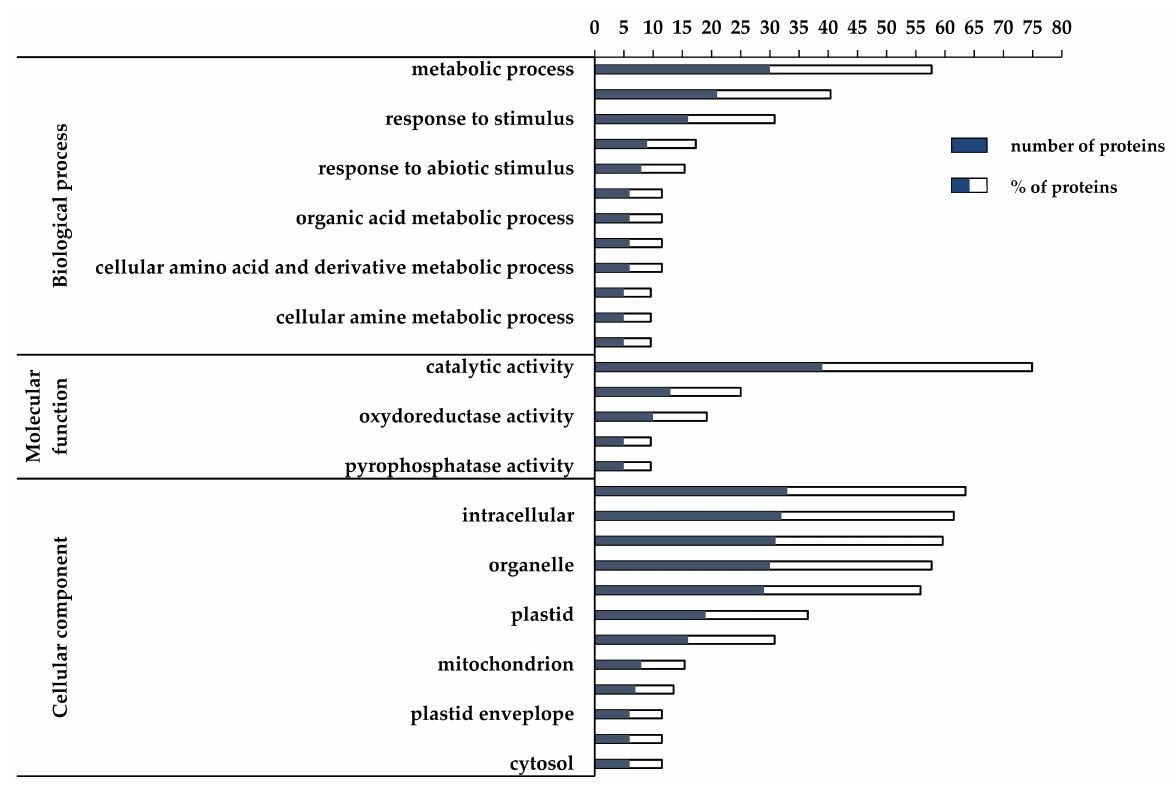
Figure 4. GO functional classification of the downregulated DEPs. The blue bar represents the number of downregulated proteins included in each GO term, whereas the sum of blue and white bars represents the corresponding protein percentage. As for the downregulated DEPs, 30/52 DEPs (58%) matched with the “metabolic process term” (GO:0008152, FDR < 0.001) and 16/52 DEPs (31%) were included in the “response to stimulus” term (GO:0050896, FDR < 0.01). The last term comprises “response to abiotic stimulus”, “response to stress”, and “response to cold” (Figure